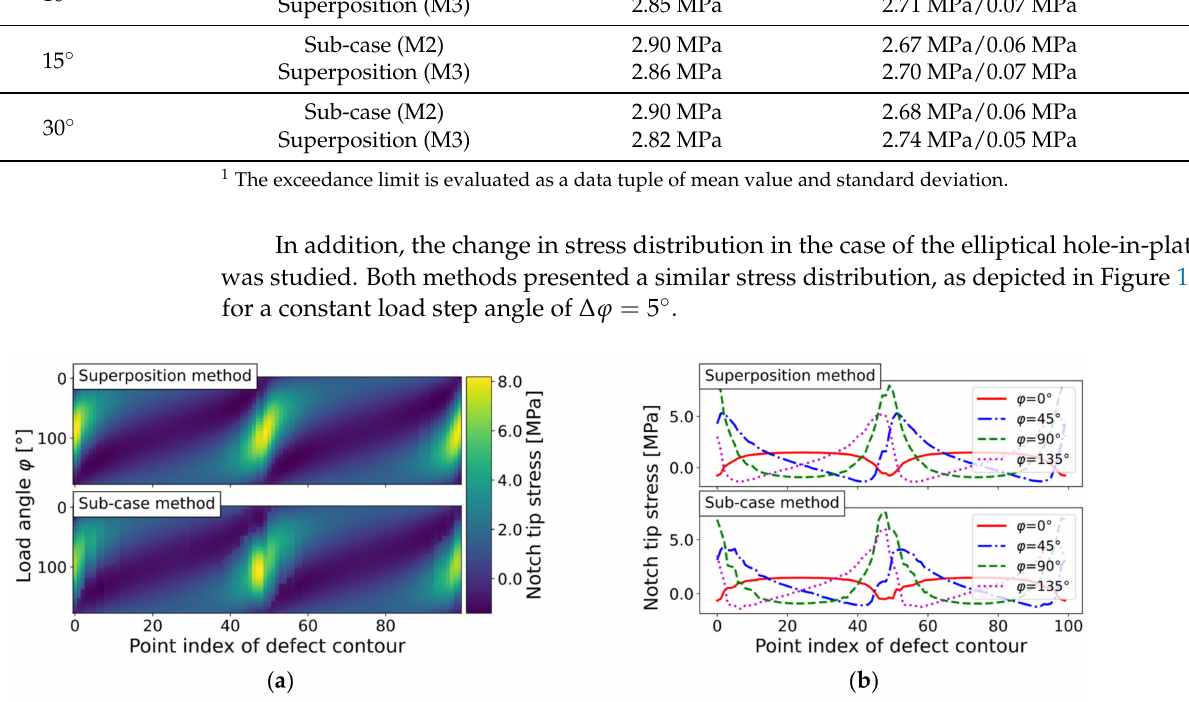
Figure 13. Notch tip stress evaluation of elliptical hole-in-plate (mesh ‘ellipsis_lin_rot0deg_v1’) by sub-case and superposition methods for incremental load step of ∆ ϕ = 5 ◦ : ( a ) Level plots; and ( b ) Course along defect